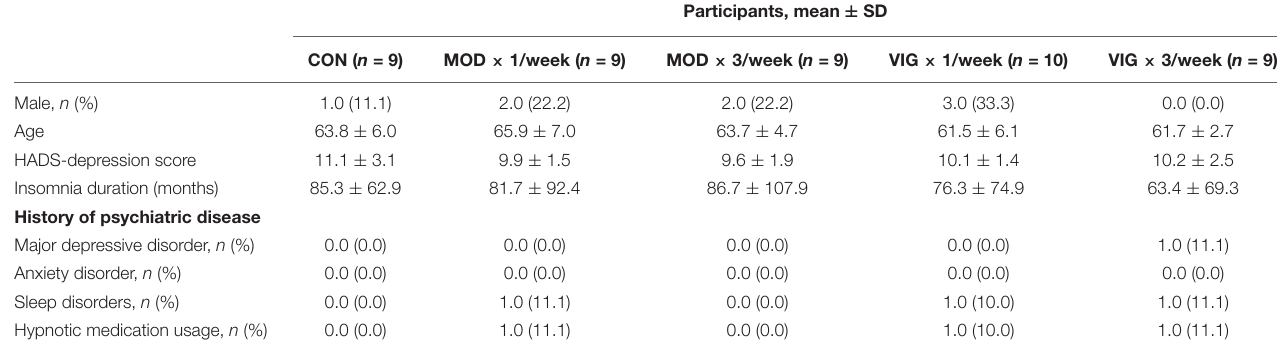
TABLE 1 | Baseline characteristics of